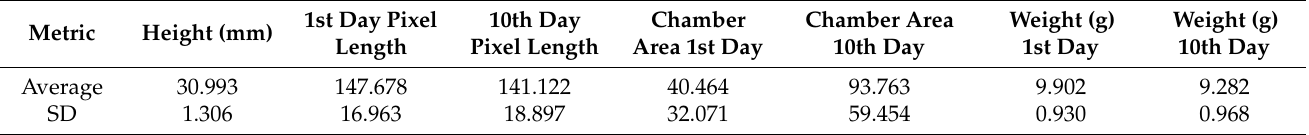
Figure 10. The variation in the air cell size for each egg between the first day of storage and the 10th day under accelerated degradation conditions. Table 3. Data exploration analysis for weight and air cell size of stored